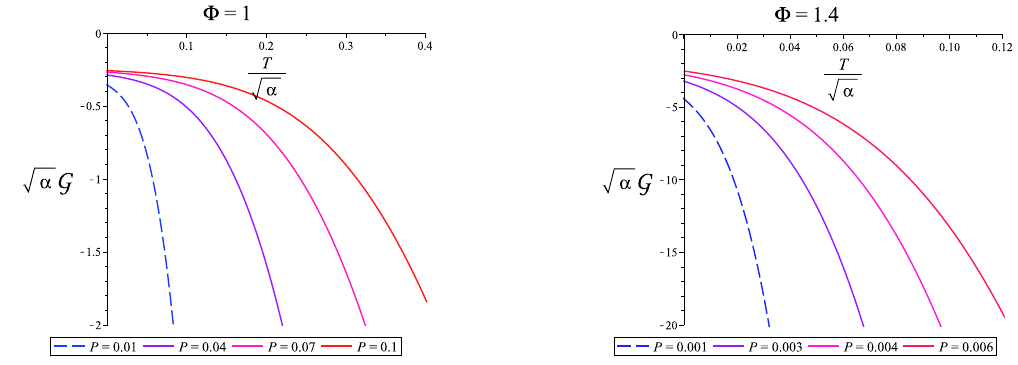
Figure 12 . Thermodynamic potential in grand canonical ensemble, for (cid:8) = 1 and (cid:8) = 1 :